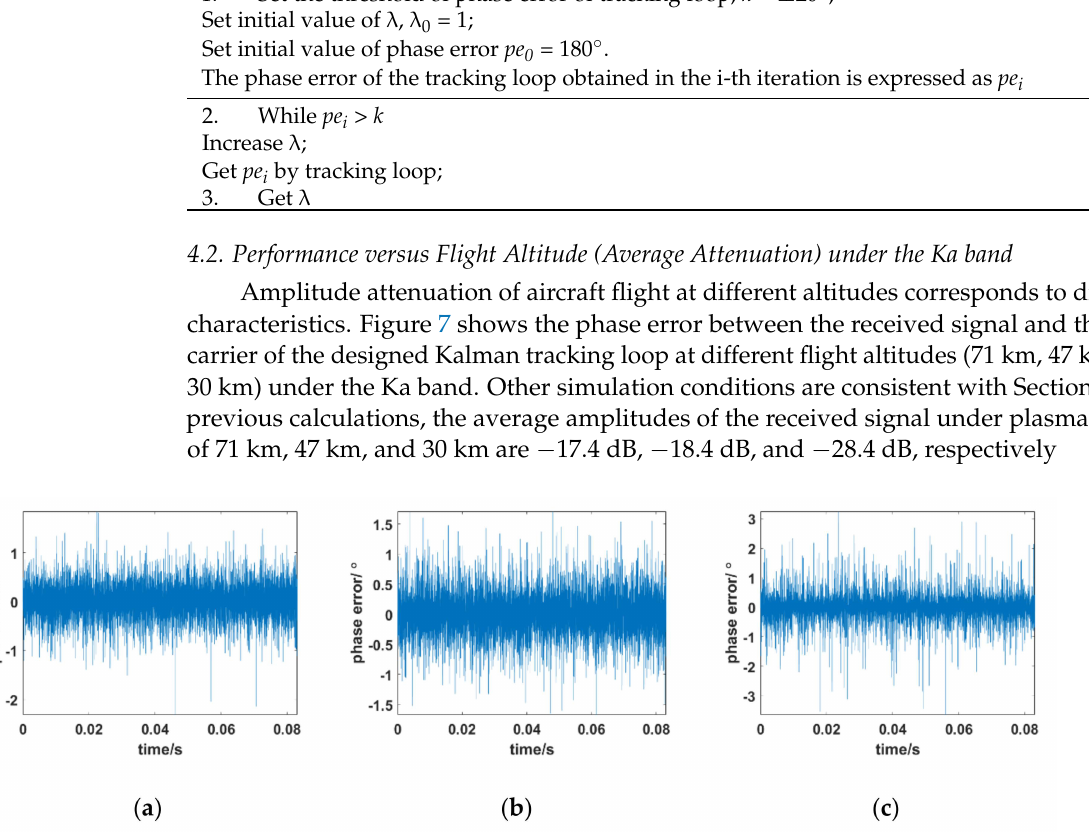
Figure 7. Phase error between the received signal and local carrier of the designed Kalman tracking loop at different flight altitudes. ( a ) 71 km ( b ) 47 km ( c ) 30